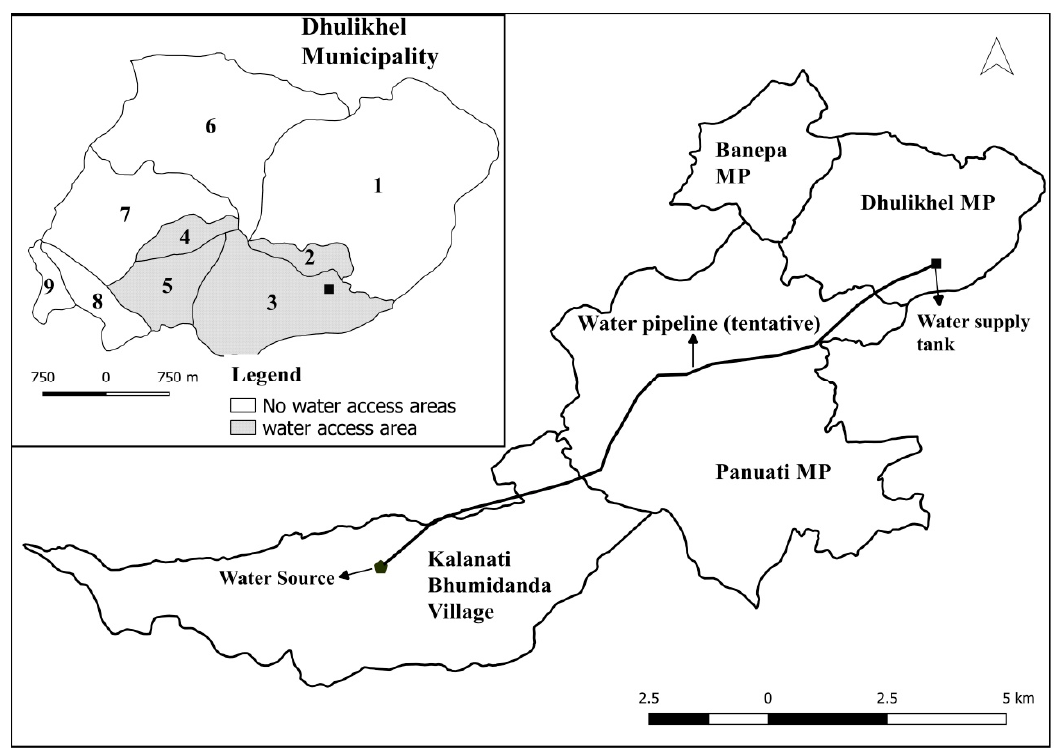
Figure 5. Map showing Rosi river water intakes, pipe routes, Dhulikhel reservoir, and boundaries of water supply system.